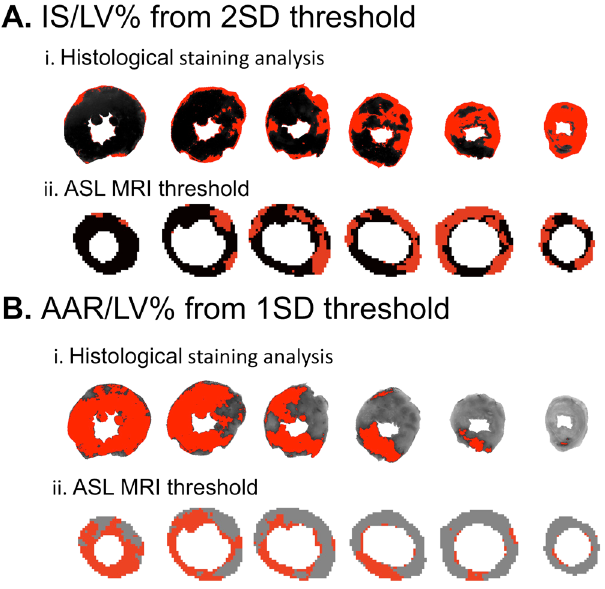
Figure 7. Comparison of histological staining regional analysis 1 SD and 2 SD thresholds for ASL perfusion mapping. ( A) Quantification of IS/LV% from TTC histological staining using ImageJ planimetry where red signal represents infarcted tissue (i). ASL perfusion mapping analyzed with 2 SD threshold for IS/LV% with red signal representing putative infarct region (ii). Histology and MR images have different slice thicknesses and cardiac contraction states and therefore should not be compared slice-by-slice. ( B) Quantification of AAR/LV% from histological staining using ImageJ planimetry where grey signal representing putative AAR region and red signal indicating normal Evans blue perfusion (i). ASL perfusion mapping analyzed with 1 SD threshold for AAR/LV% with grey signal representing putative AAR region and red signal indicating normal perfusion